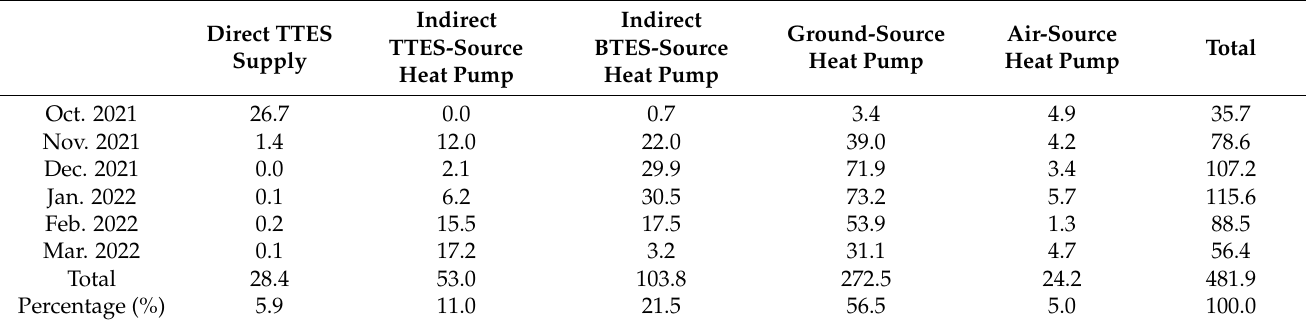
Figure 6. Daily heating supply of each component. The empirical operational results obtained during the analysis period are summa- rized in Tables 4 and 5. The total thermal energy supply during the heating period was 489.2 MWh. The indirect TTES heat pump thermal supply refers to the energy supplied from the evaporation heat source of the heat pump when the heat supply is impeded because the temperature of the warm water of the seasonal latent heat storage system is lower than the designed temperature (that is, 40 ◦ C). The direct and indirect thermal supply from the TTES accounted for 38.4% of the total energy supply. Table 4. Monthly heating supply of the system operation.